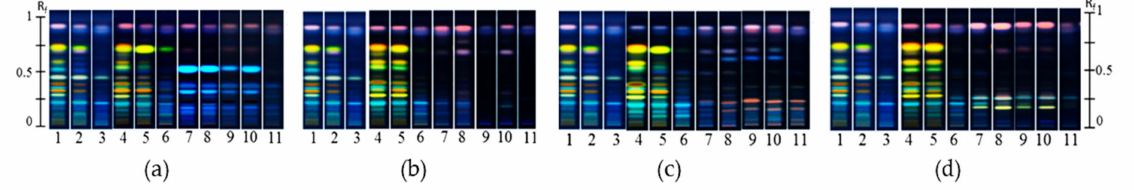
Figure 5. High performance thin layer chromatograms of the co-culture of the 11(2) strain and four fungal pathogens. ( a ), 11(2) against Alternaria alternata ; ( b ), 11(2) against Botrytis cinerea ; ( c ), 11(2) against Colletotrichum acutatum ; ( d ), 11(2) against Fusarium oxysporum . In all plates, lane 1: internal zone of the colony control of 11(2), lane 2: external border of the 11(2) colony control, lane 3; peripheral medium around the 11(2) colony control: lanes 4/5: internal and border side of the 11(2) colony in co-culture conditions, respectively; lane 6: confrontation zone extract between the 11(2) strain and the corresponding pathogen: lanes 7/8 border and internal side, of the pathogen under co-culture conditions, respectively; lanes 9–11 peripheral medium, border and inner side extracts of the fungal pathogen control